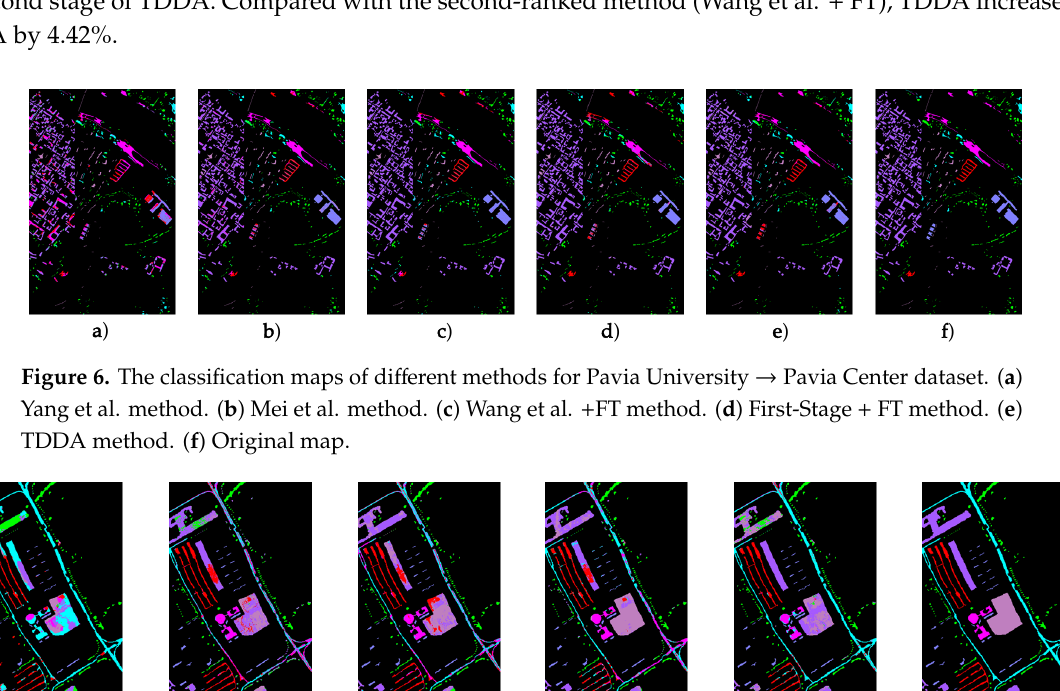
Figure 7. The classification maps of different methods on Pavia Center → Pavia University dataset.